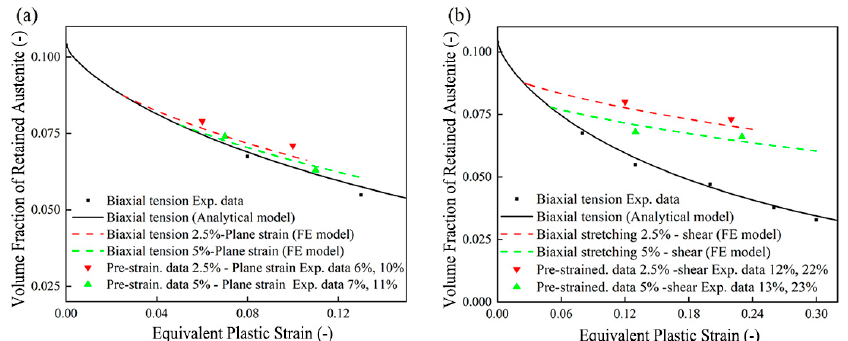
Figure 23. Distribution of retained austenite with varying EPS under di ff erent loading paths: ( a ) Comparison of the experimental results of the VFRA test and the VFRA prediction results of the FE model under Biaxial tension-plane strain tension at 6%, 10%, 7%, and 11% EPS. ( b ) Comparison of the experimental results of the VFRA test and the VFRA prediction results of the FE model under Biaxial tension-pure shear at 12%, 22%, 13%, and 23% EPS.